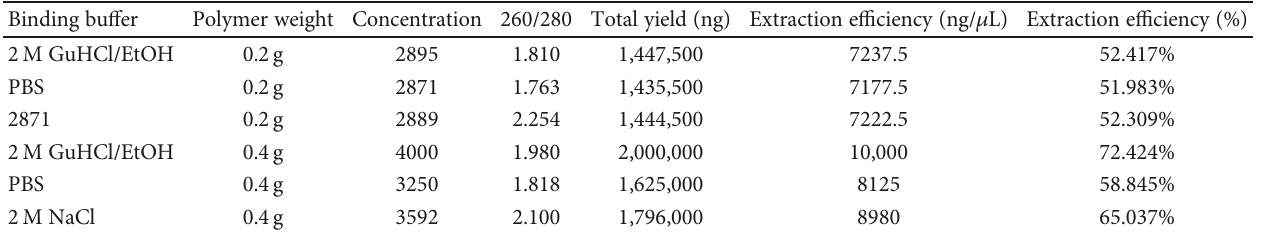
Table 5: Extraction e ffi ciencies and total yields of DNA for the polymer composite under di ff erent weights and binding bu ff ers. Binding bu ff er